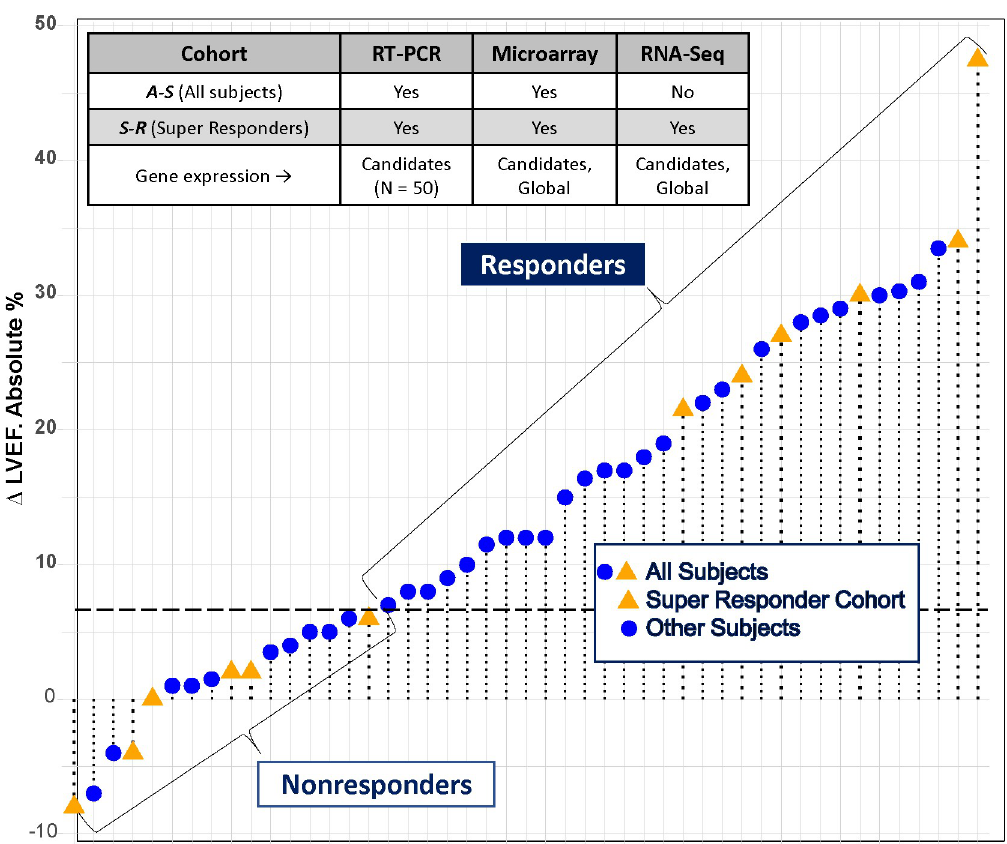
Fig 1. Summary of LVEF changes from baseline. LVEF change from baseline in the 47 patients comprising the All-Subjects ( A-S ) Cohort, and the 12 Subjects in the Super-Responder ( S-R ) subcohort. Messenger RNA measurement platforms, Responder/Nonresponder reverse remodeling phenotype and types of gene expression changes measured in each platform are also given.